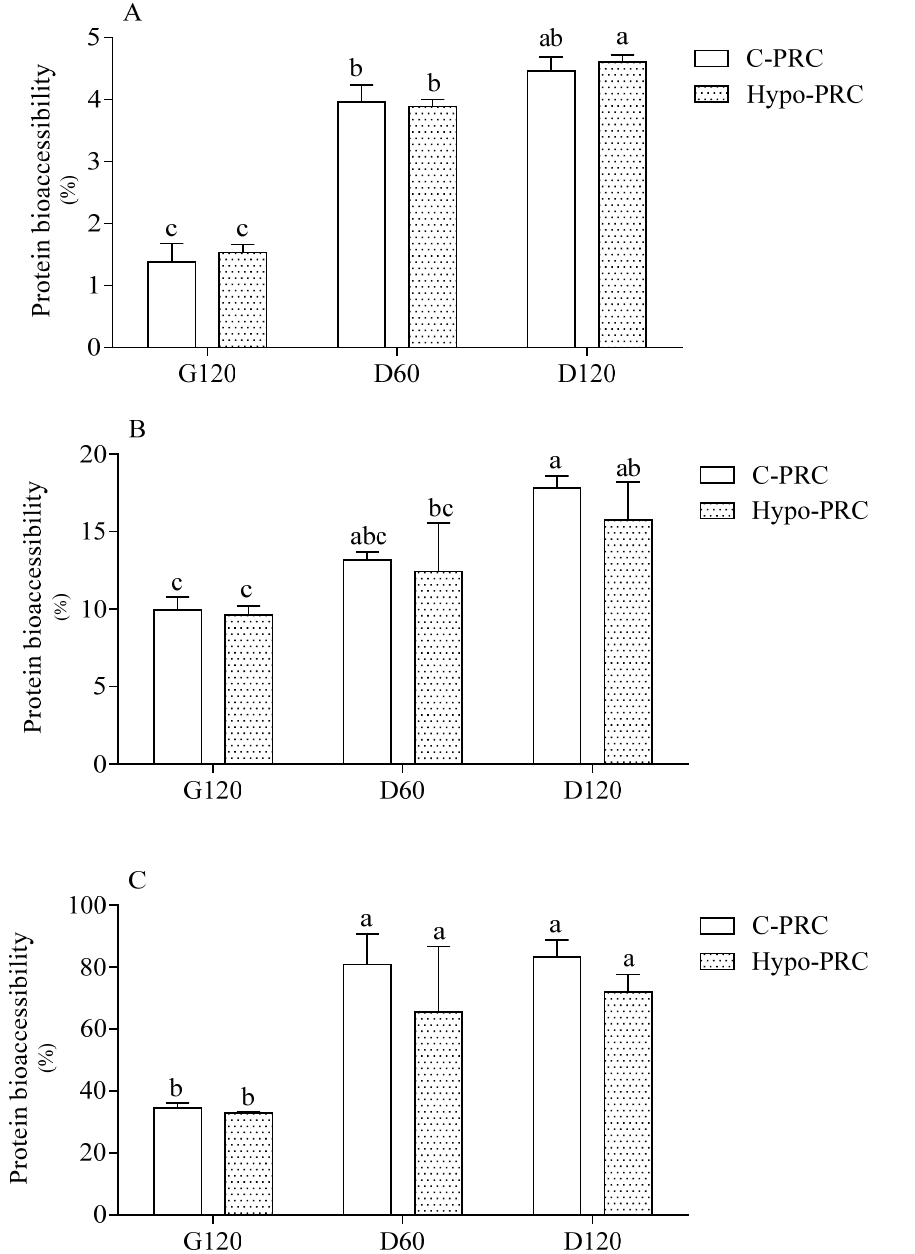
Figure 1. Protein bioaccessibility assessed by OPA ( A ) and Coomassie assay ( B ) and absorbance at 280 nm ( C ) in conventional Parmigiano Reggiano cheese (C-PRC) and hyposodic Parmigiano Reggiano cheese (Hypo-PRC) at different digestion times. Data are means ± SD of 3 independent in vitro digestions, each analyzed in triplicate. Protein bioaccessibility is expressed as % and it was calculated as the ratio × 100 between the protein mass in the digestion fluid and the total protein mass in the original undigested PRC. Statistical analysis was by the one-way ANOVA (A and C: p < 0.0001; B: p < 0.005) with Tukey’s post-hoc test (different letters indicate significant differences). G120: end of gastric phase; D60: 60 min of duodenal phase; D120: end of duodenal phase.